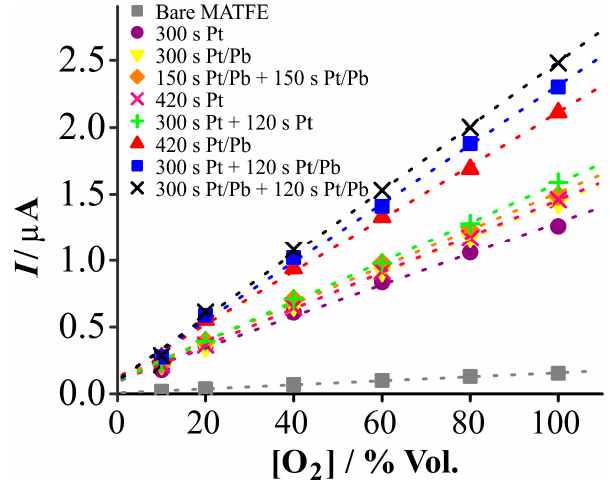
Figure 5. Plots of absolute current vs. oxygen concentration for the reduction of 10–100% vol. oxygen in [N 8,2,2,2 ][NTf 2 ] on: a recessed MATFE ( ■ ), 300 s Pt ( ● ), 300 s Pt/Pb ( ▼ ) 150 s Pt/Pb + 150 s Pt/Pb ( ♦ ),